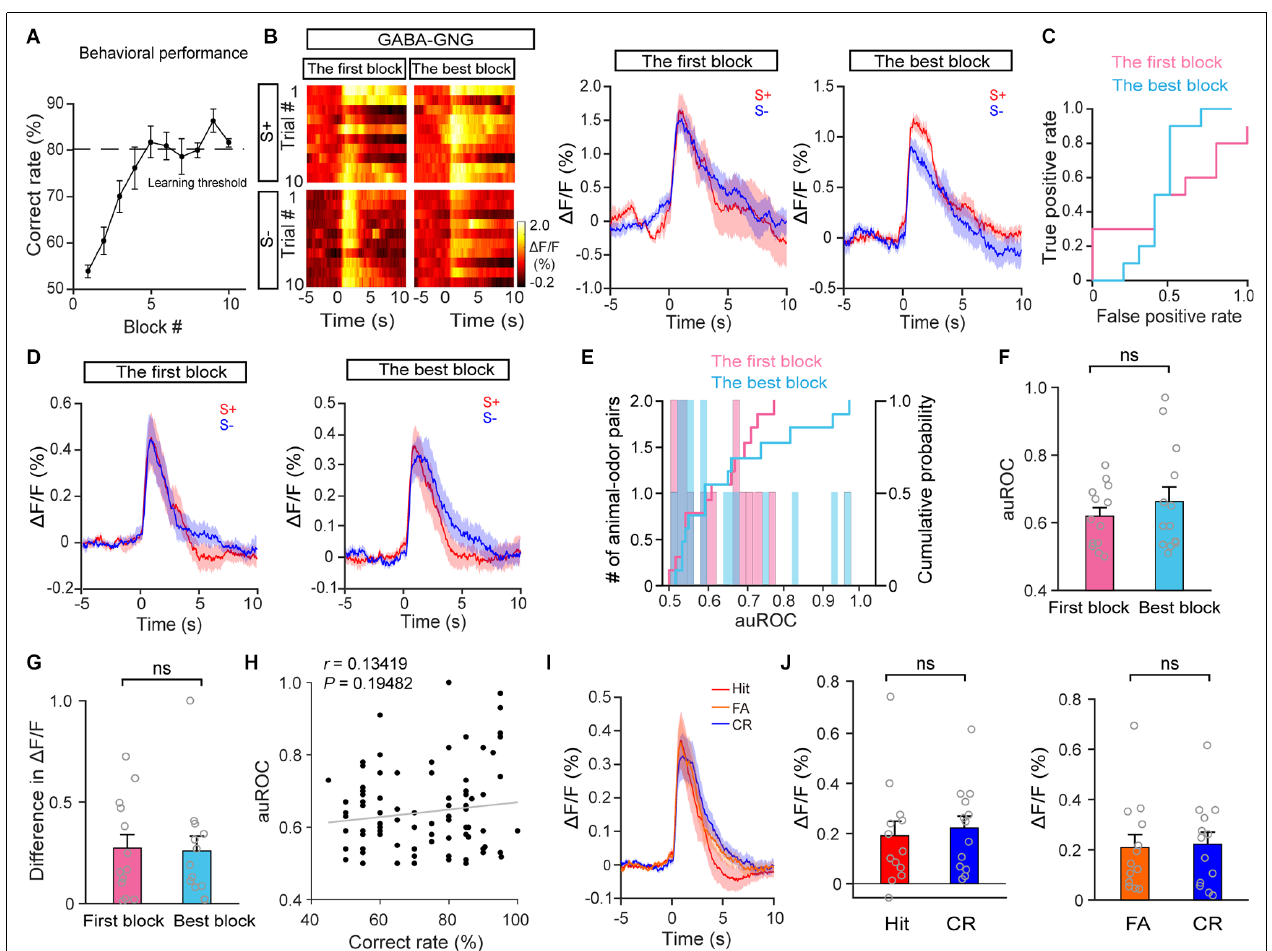
FIGURE 6 | The response profiles of HDB GABAergic neurons in S+ trials and S– trials during the go/no-go task. (A) Odor discrimination performance during the last session in the go/no-go task. (B) Representative heat maps and corresponding traces of GABAergic responses in S+ and S– trials in the first block and the best block during the go/no-go task. (C) ROC graph for the S+ and S – responses in the first block and the best block shown in (B) . (D) Averaged traces of GABAergic responses in S+ and S– trials in the first block and the best block across all animal–odor pairs ( n = 26 animal–odor pairs from 13 mice). (E) Histograms and cumulative probability of auROCs in the first block and the best block. (F,G) Comparison of auROCs (F) and difference in ∆ F/F (G) in the first block and the best block [ (F) Paired t -test, t (12) = − 0.78, P = 0.45; (G) paired t -test, t (12) = 0.12, P = 0.91]. (H) The auROCs of GABAergic responses plotted against the correct rate during the go/no-go task (Linear regression, r = 0.13, P = 0.19, n = 95 blocks). (I,J) Comparison of averaged cholinergic responses in Hit, FA, and CR trials [ (J) Hit vs. CR, paired t -test, t (12) = − 0.80, P = 0.44, FA vs. CR, Wilcoxon signed-rank test, z = − 0.035, P = 0.97]. ns, no